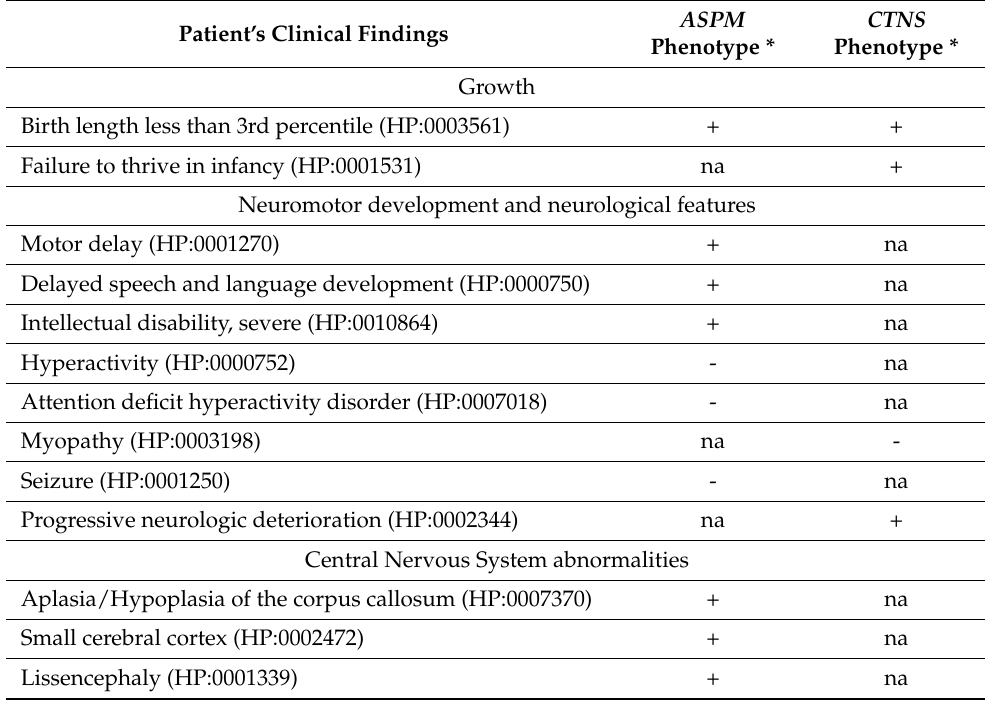
Table 1. Genotype–phenotype correlation for ASPM and CTN